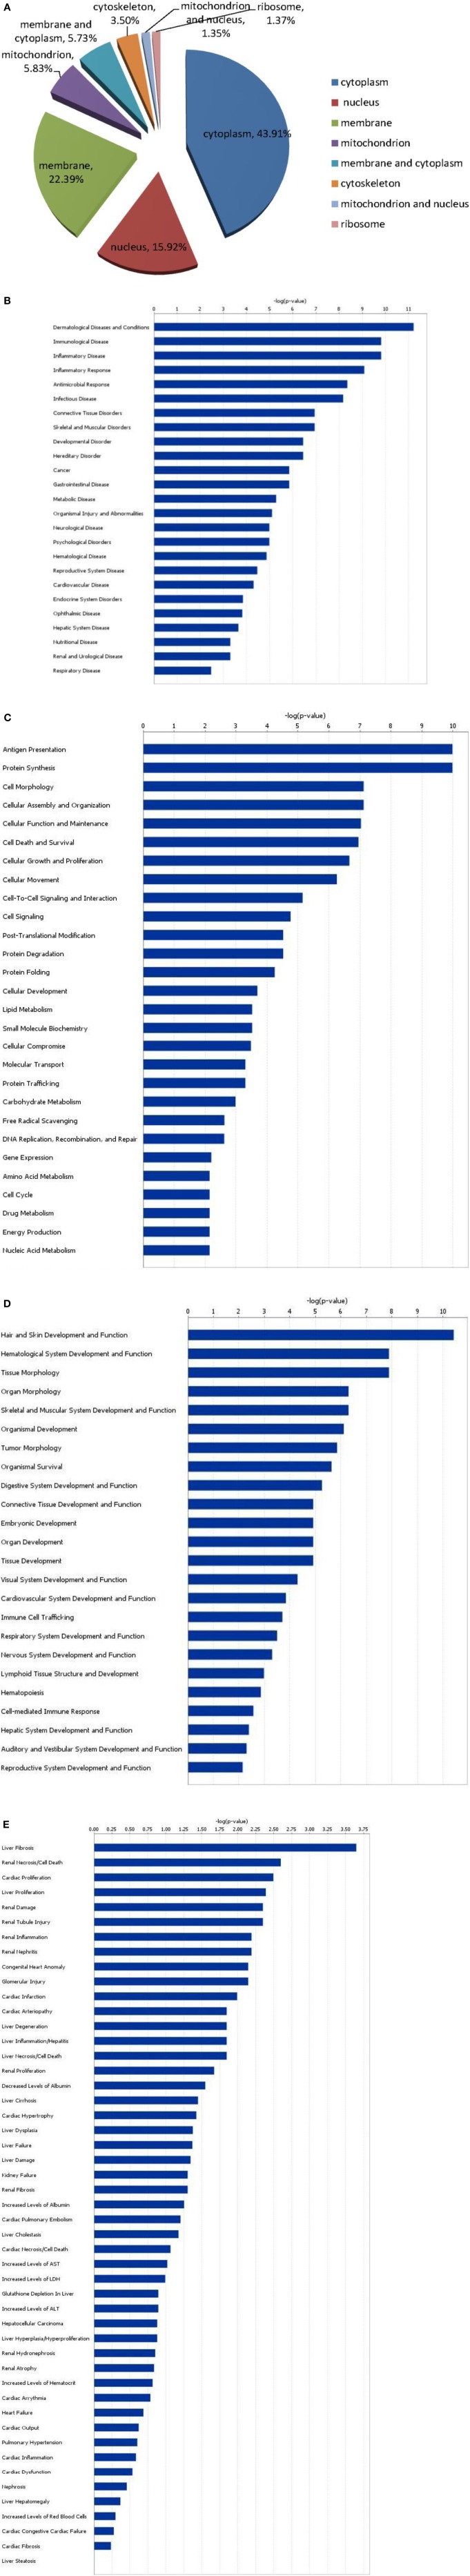
Subcellular localization of differentially expressed proteins (A), and functional characterization of up-regulated and down-regulated proteins (B–E). (B) Diseases and disorders; (C) molecular and cellular functions; (D) physiological system development; (E) functions and toxicity functions.